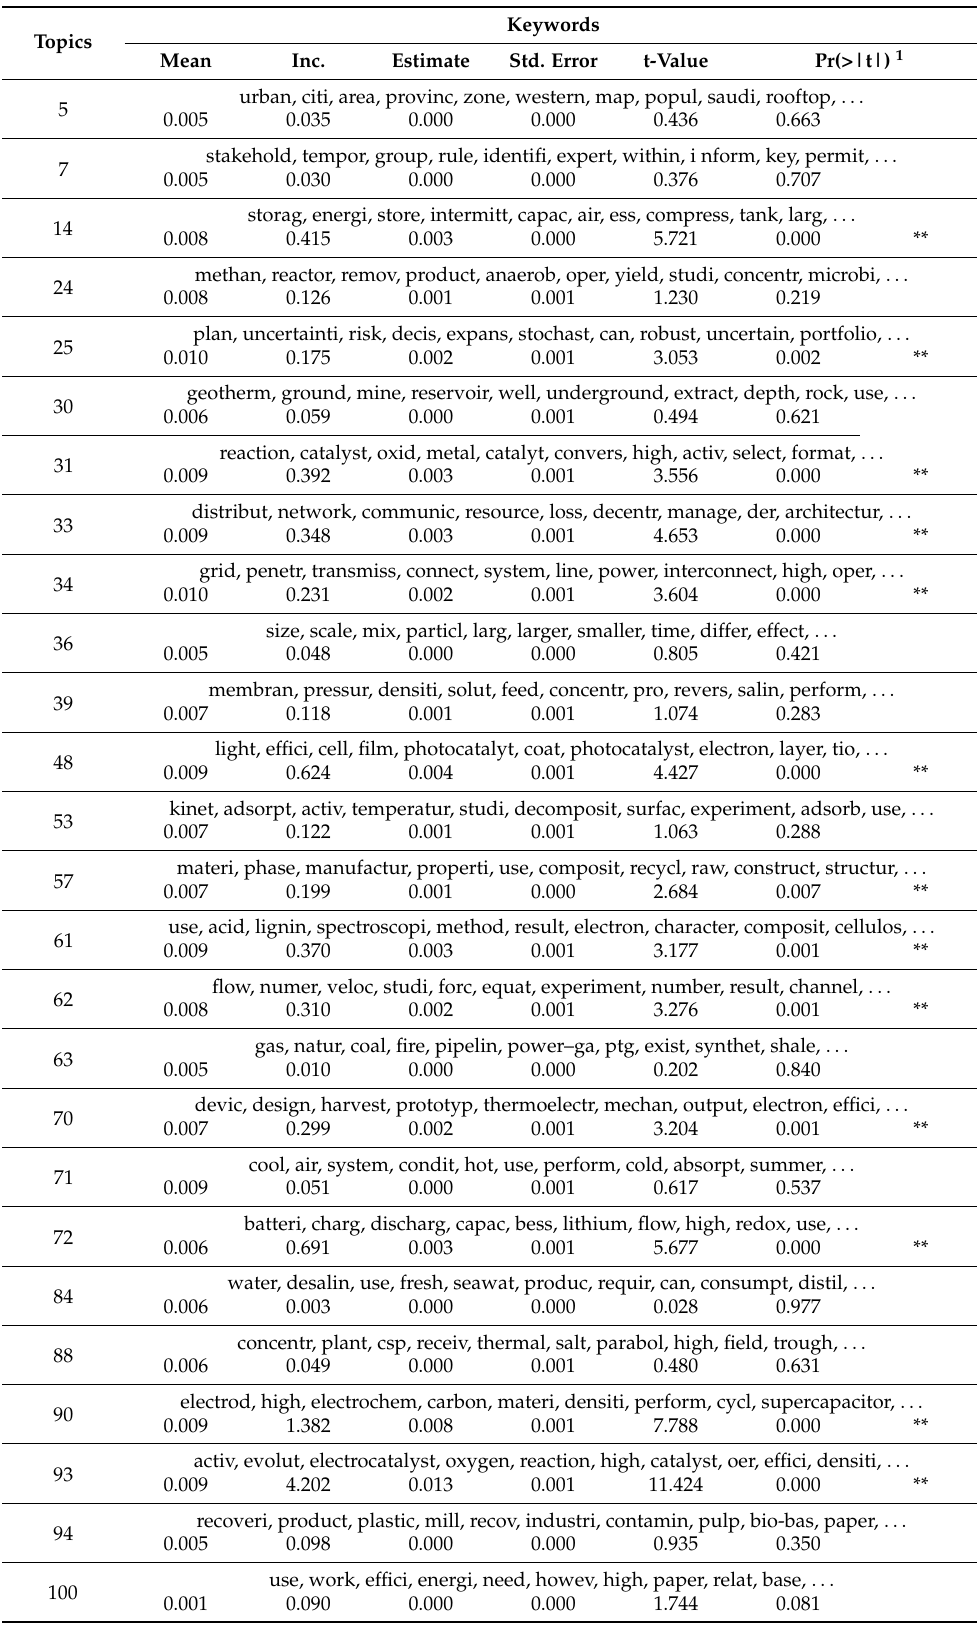
Table 5. Topics selected as weak